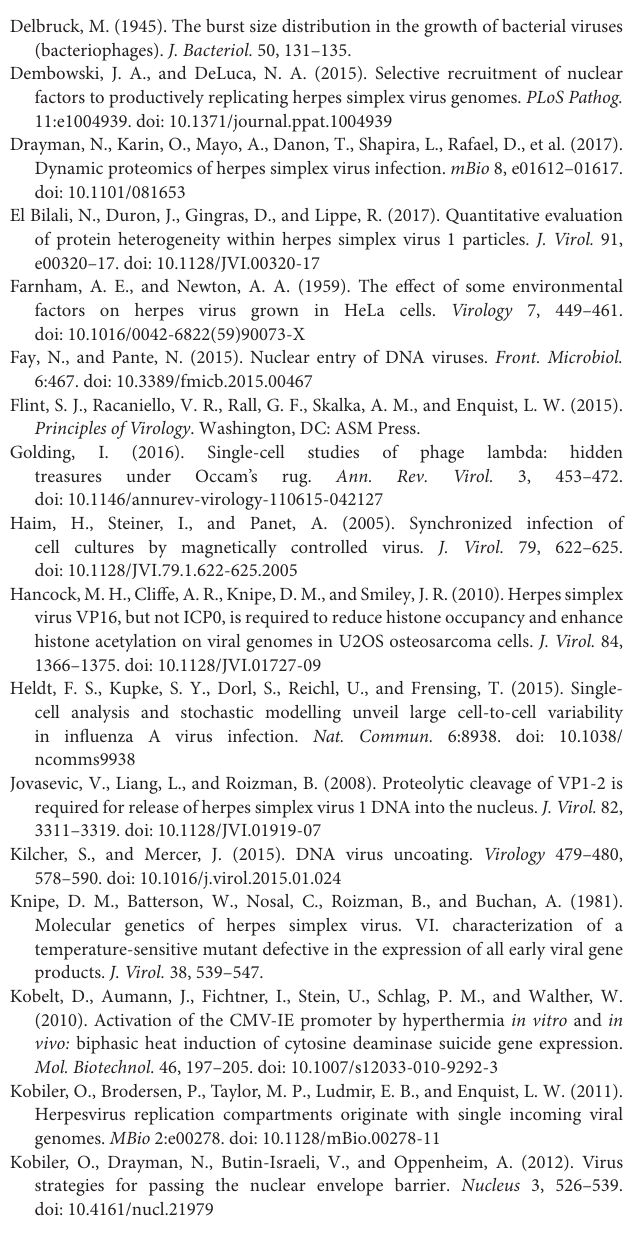
Supplementary Figure 2 | Cell cycle analysis of growing and arrested cells. Cells were grown in 10% FBS for 24h ( right ) or in 0.1% FBS for 48h ( left ). The cells were fixed, labeled with propidium iodide and FACS analyzed for fluorescence levels in three replicative experiments (one panel for each experiment). In each histogram, the number of cells was plotted as the function of the fluorescence from the propidium iodide in arbitrary units (AU). Supplementary Figure 3 | Correlation between fluorescence onset time and fluorescence levels. Cells were infected at MOI20 with OK11 recombinant virus